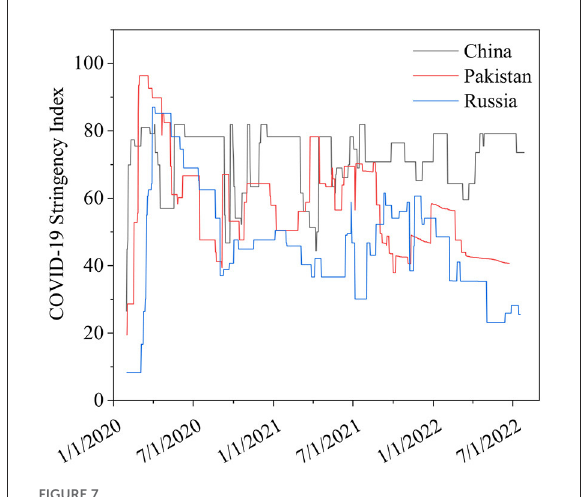
FIGURE7 Non-Vaccination and Vaccinated Indices. Data source: Hale et al. (72), February 3, 2020–August 14,